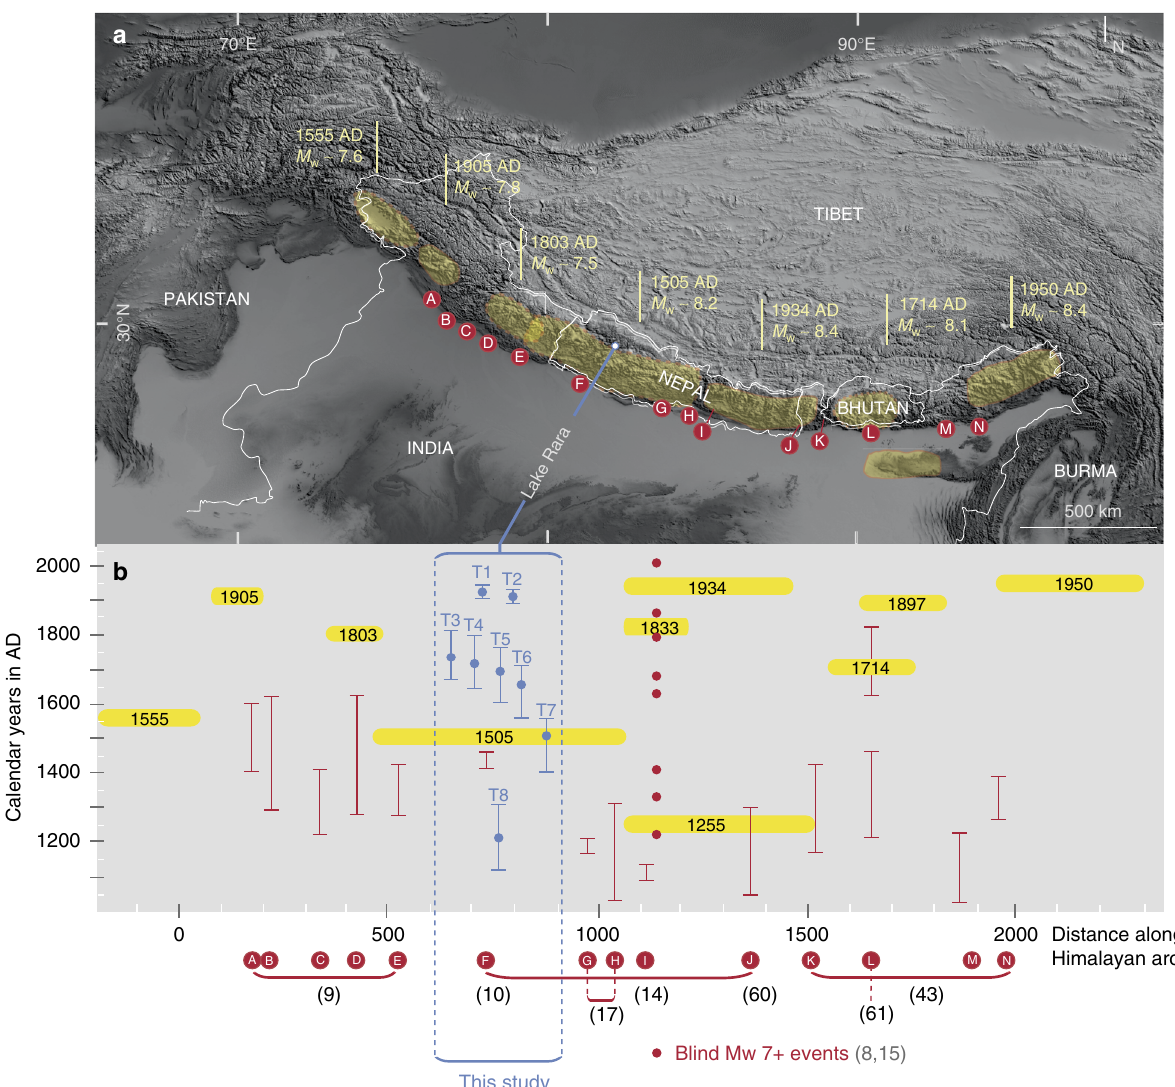
Fig. 4 Overview of historical and paleoseismic data along the Himalayan front. The map is modi fi ed and updated from ref. 59 . a Digital terrain model of the Himalayan region. Yellow areas correspond to inferred ruptures of historical earthquakes (the surface ruptures of the 1255 AD and 1833 AD earthquakes overlap that of the 1934 earthquake and are not represented); their timing and magnitude are indicated. Red dots labelled A to N represent paleoseismic trenches along the MFT; references are given in parentheses below plot ( b ). b Ages and extents of historical Himalayan M w > ∼ 7.5 earthquakes (horizontal yellow bars). Red vertical bars re fl ect 14 C ages that bracket the age of surface ruptures in calendar years AD, with 2 σ uncertainties. Blue vertical bars represent the turbidite ages extracted from the age-depth model (2 σ ; this study); blue dots indicate the weighted mean age. Data from refs. 8 –